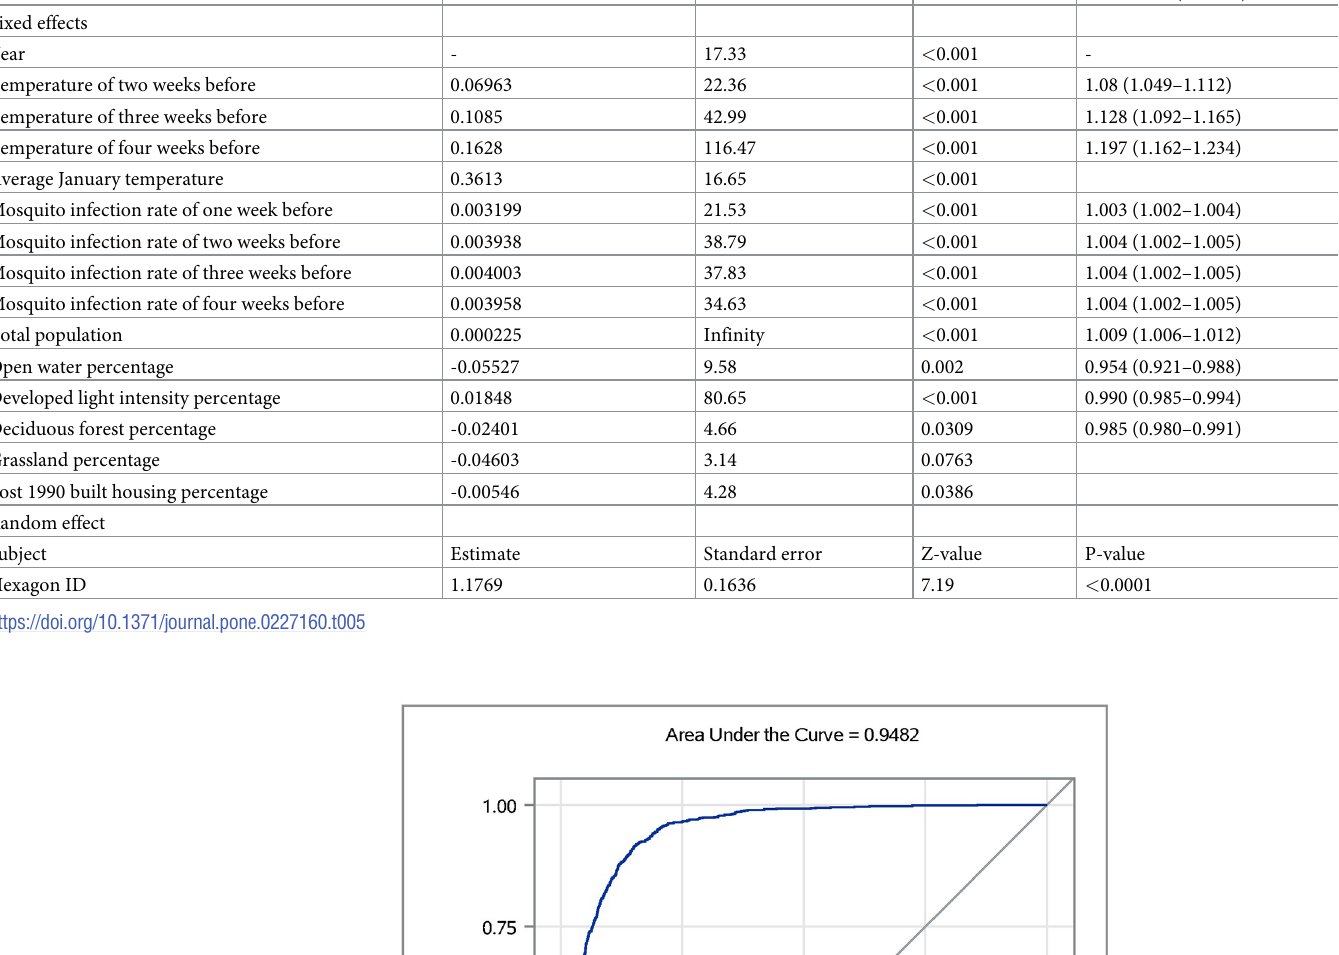
Table 5. Model parameters for the best model using weather, land cover, mosquito infection, and demographic factors to predict the occurrence of WNV human cases in Chicago region. Variable